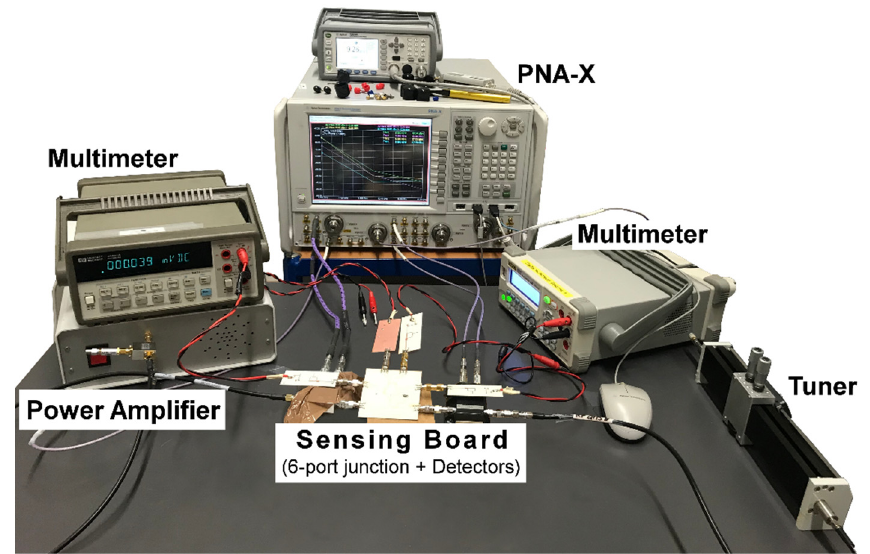
Figure 14. Measurement setup for detector nonlinearity investigation. It includes the sensing board (six-port junction and detectors) and the variable load implemented with a mechanical tuner; the voltages are detected by two multimeters and the signal is applied by the PNA-X.